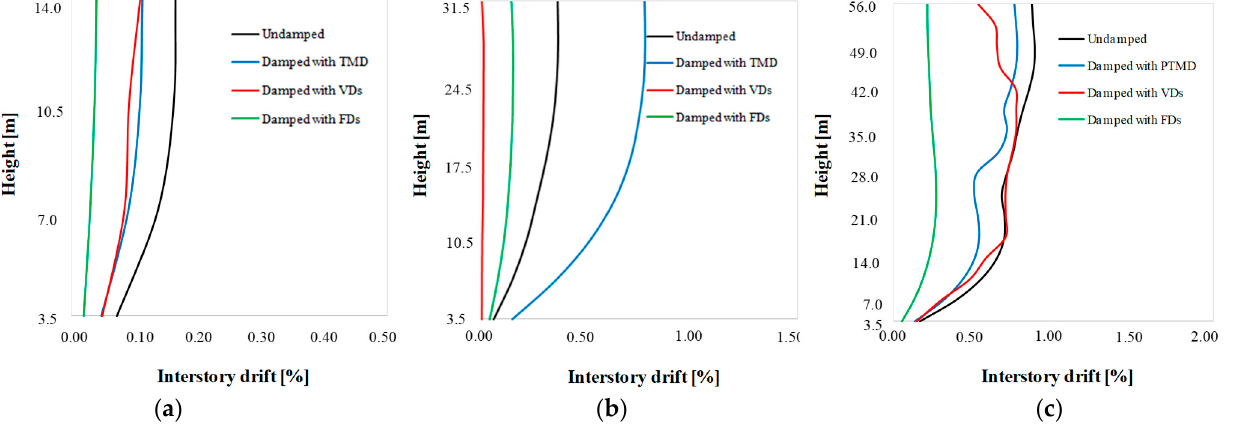
Figure 15. Maximum interstory drift for ( a ) low-rise, ( b ) mid-rise, and ( c ) high-rise building in the transversal direction.